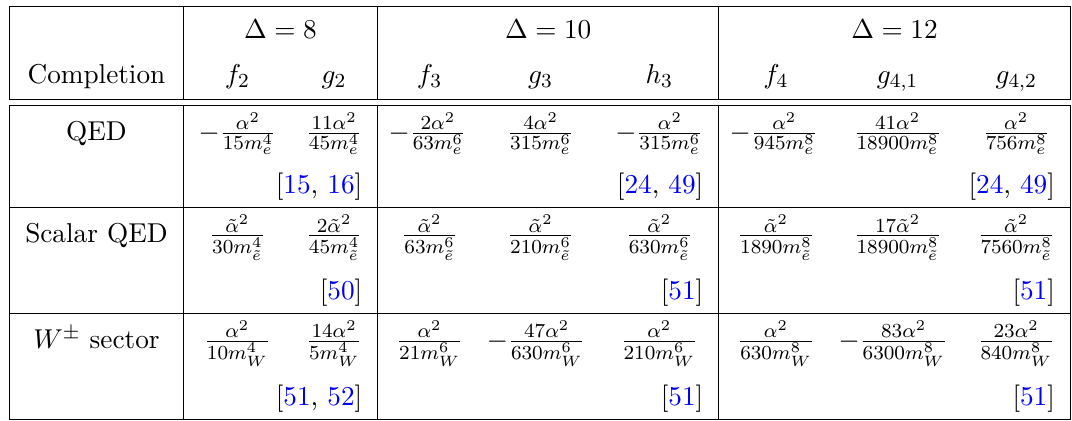
Table 3 . EFT coefficients in loop-level partial UV completions. Here M 2 = 4 m 2 that a = g 2 + f 2 , a = g 2 − f 2 1 2 16 16